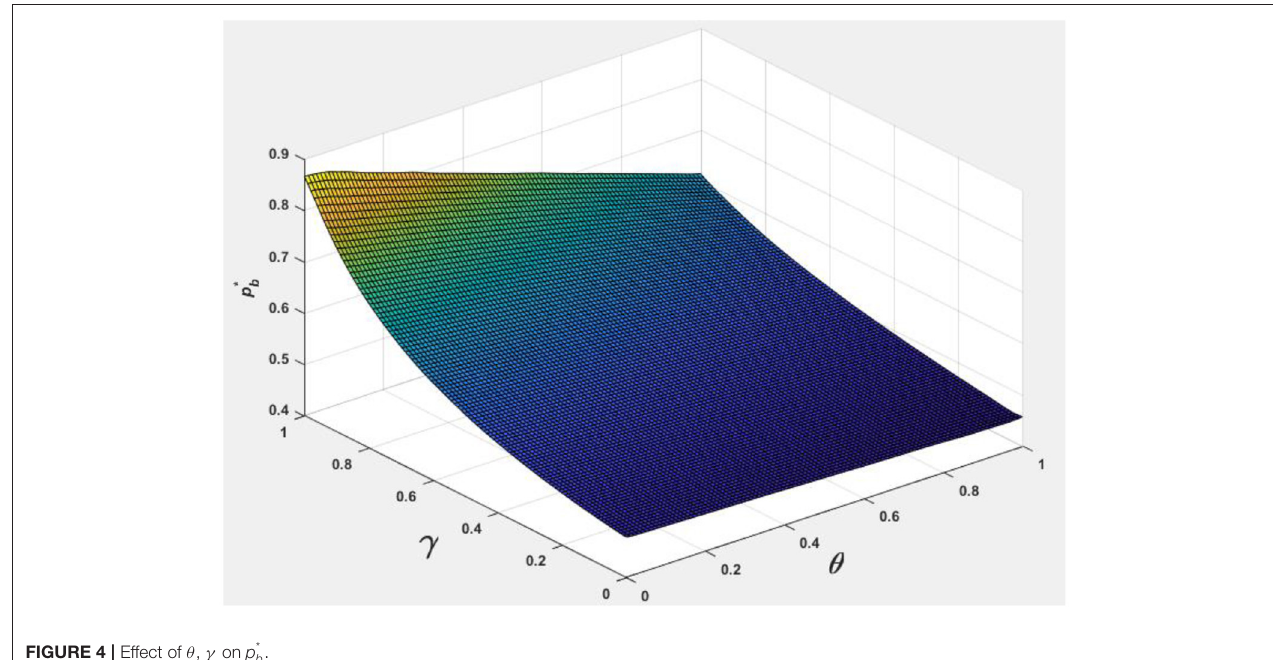
FIGURE 4 | Effect of θ , γ on p * b .